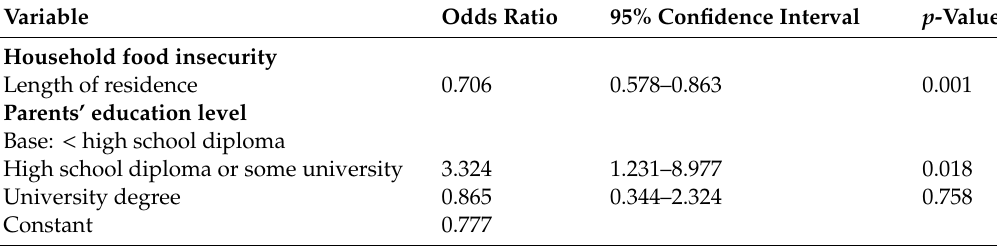
Table 3. Predictors of food insecurity